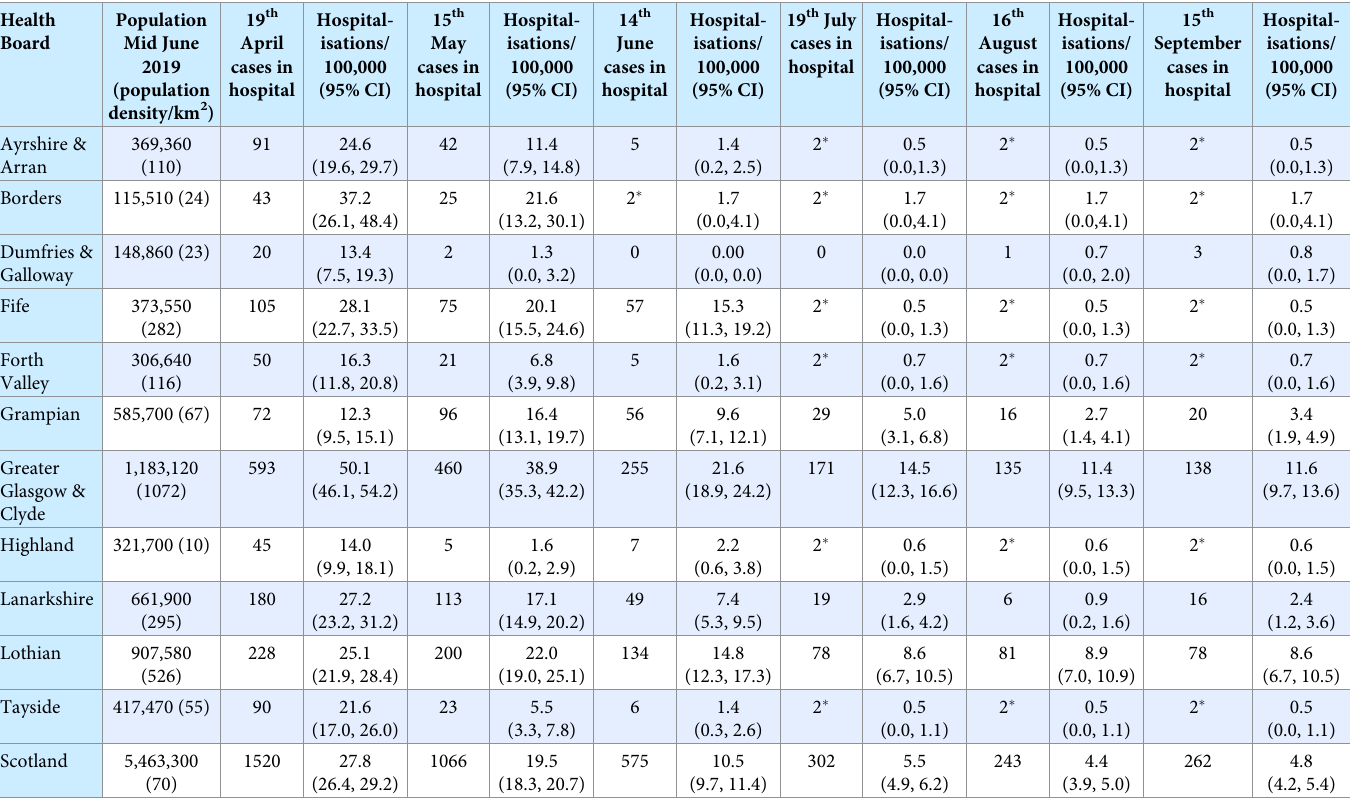
Table 1. Population, population density and confirmed COVID-19 hospitalisation rates/100,000 population at six time points during the first wave of the